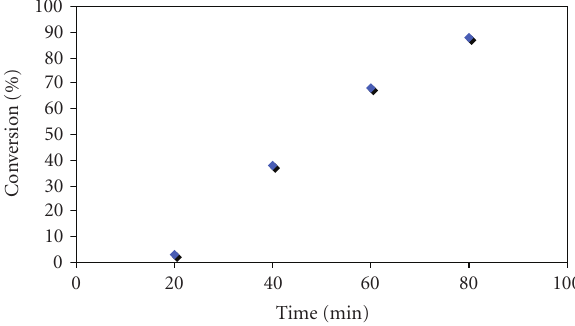
Figure 4: Conversion for L,D -LA against polymerisation